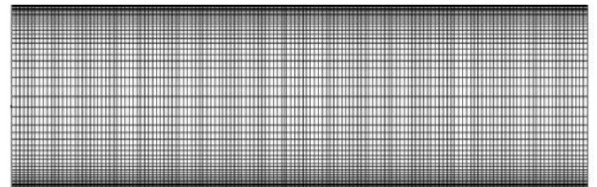
Figure 5. Mesh configuration.